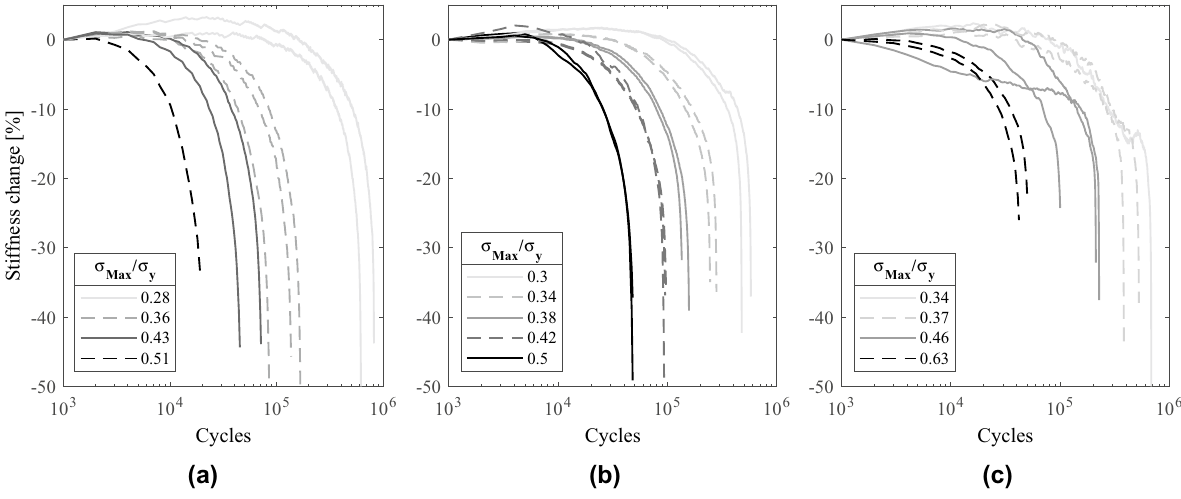
Figure 11. Evolution of stiffness under different loads and relative densities of ( a ) 10%, ( b ) 20% and ( c )